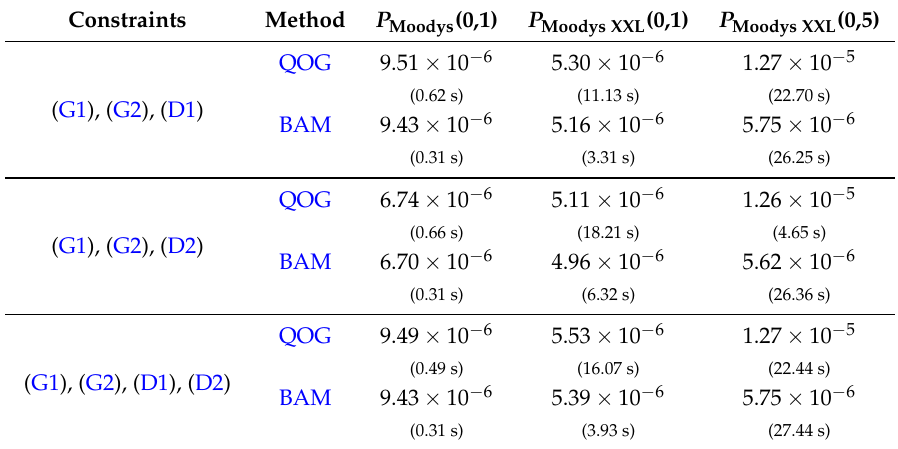
Table 3. Comparison of the additional constraints of QOG and BAM based on the averaged Frobenius norm with starting point X DMPG , for given transition matrices from Moodys in Table 0